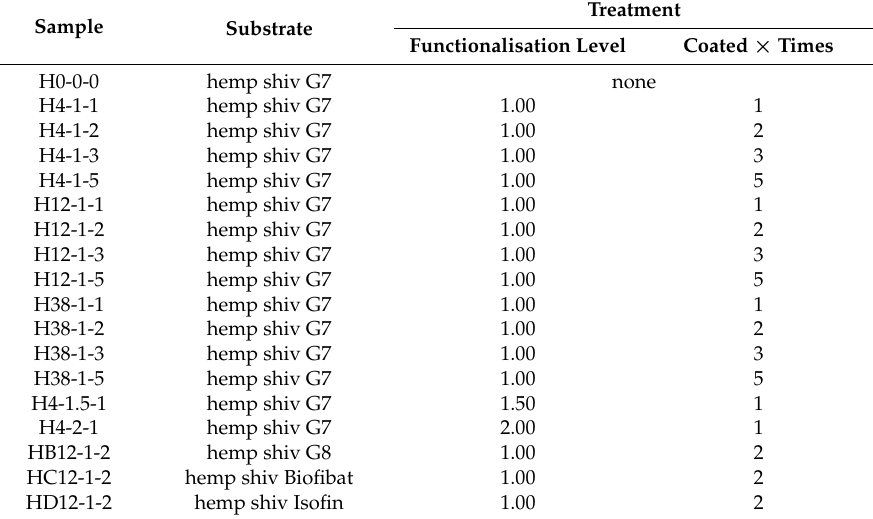
Table 1. Description of the samples with the characteristics of each treatment, where sample nomenclature refers to firstly the substrate, then silica particle size, then functionalisation level, and finally the number of coating